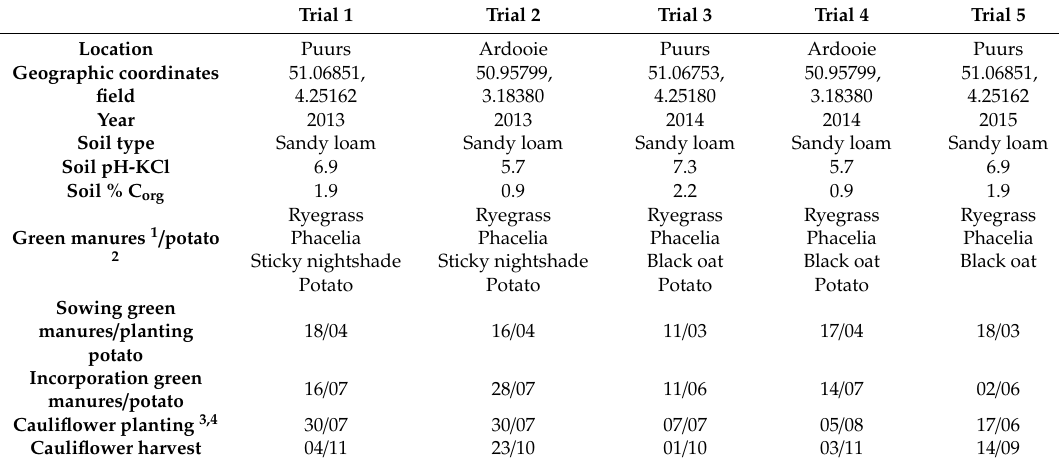
Table 5. Overview of the field trials carried out in 2013, 2014 and 2015 regarding the e ff ect of potato and green manure crops on Verticillium soil population and the impact on Verticillium wilt. The location, the soil characteristics, the cultivated crops preceding cauliflower (green manure crops and potato), and the timing of the cultivation practices are